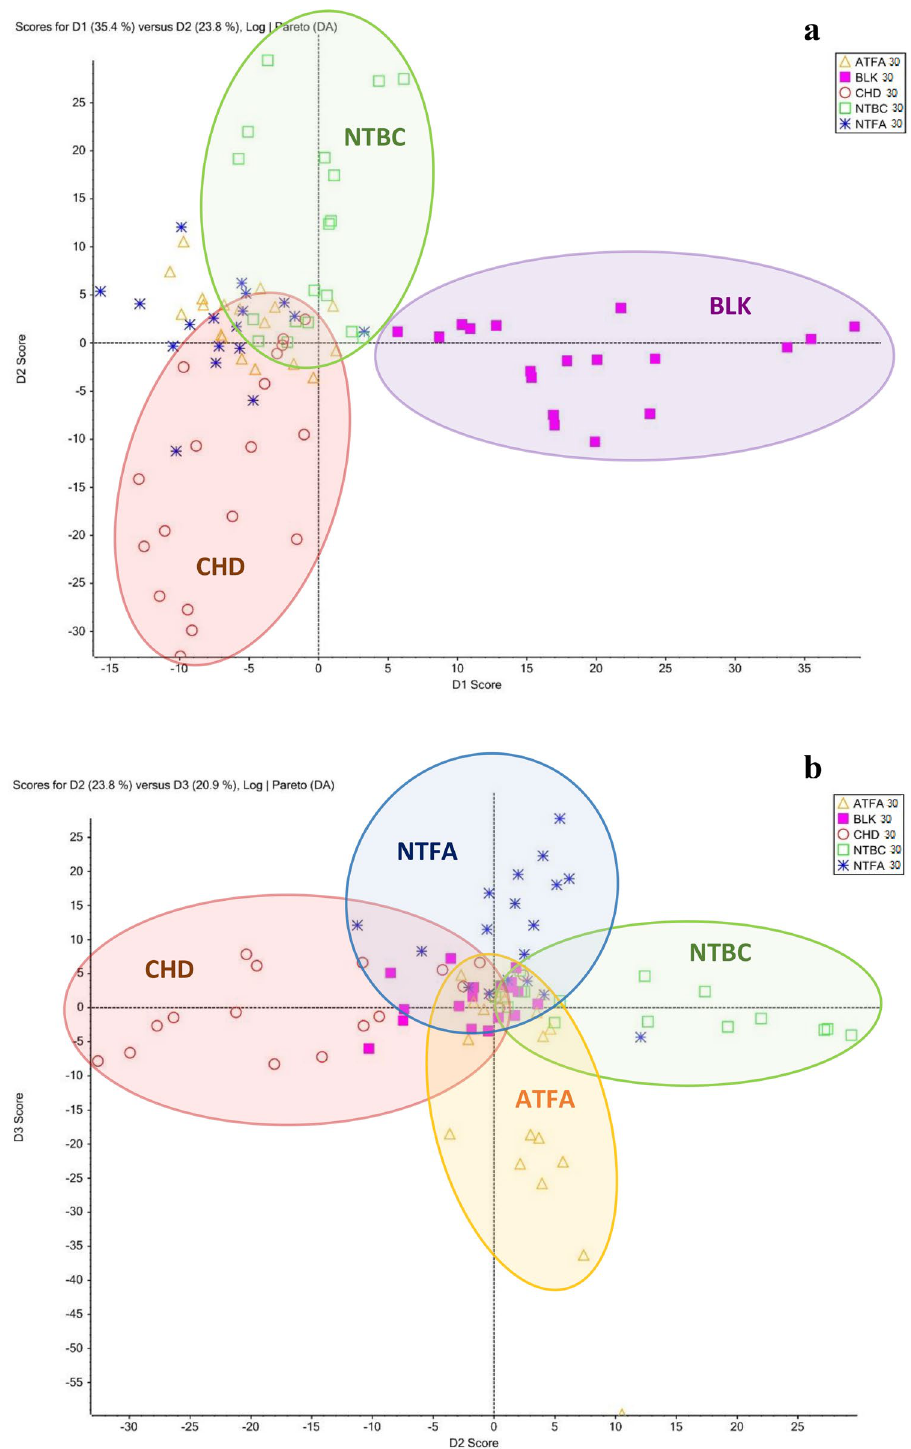
Figure 5. PCA plots for the data obtained after 30 min of yeast incubation of ( a ) the major components 1 (D1: 35.4%) and 2 (D2: 23.8%) and ( b ) the major components 2 (D2: 23.8%) and 3 (D3: 20.9%). Observations that can be associated with a variable group are delineated